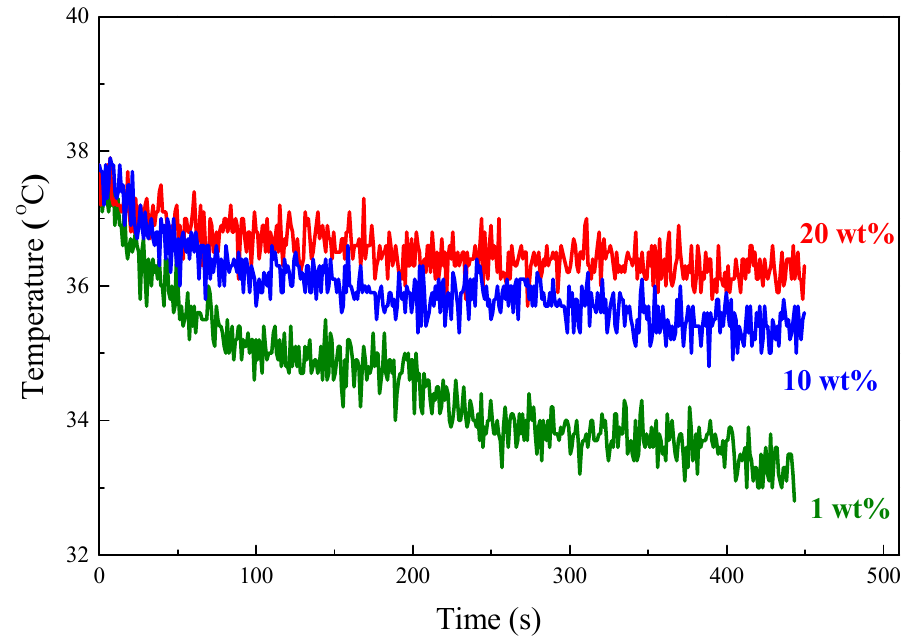
Figure 11. Heating performance of S-SEBS polymer with various amounts of TA.